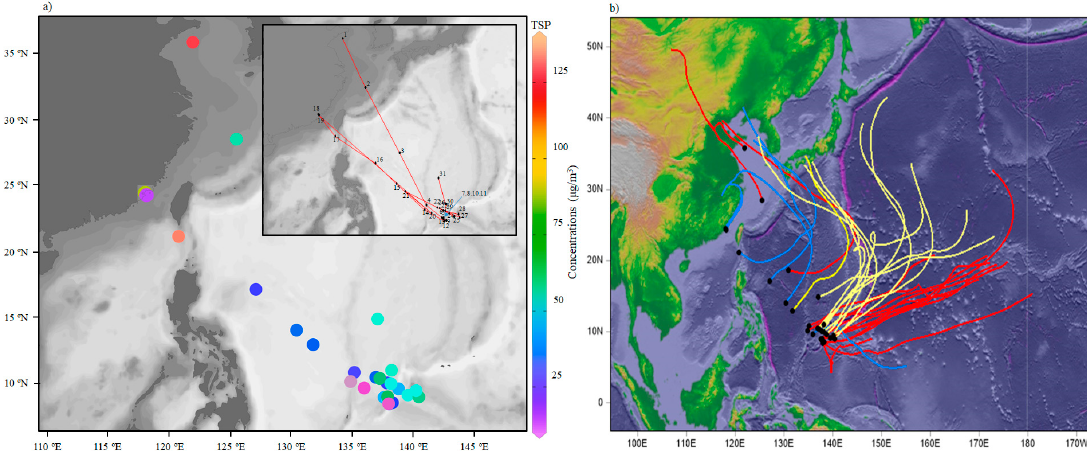
Figure 2. ( a ) Geographic distribution of TSP concentrations and start sampling sites over the western North Pacific. ( b ) Five-day back trajectories of every starting sampling site over the western North Pacific. Red, blue and yellow lines represent the start sampling site in December 2014, January and February 2015, respectively.